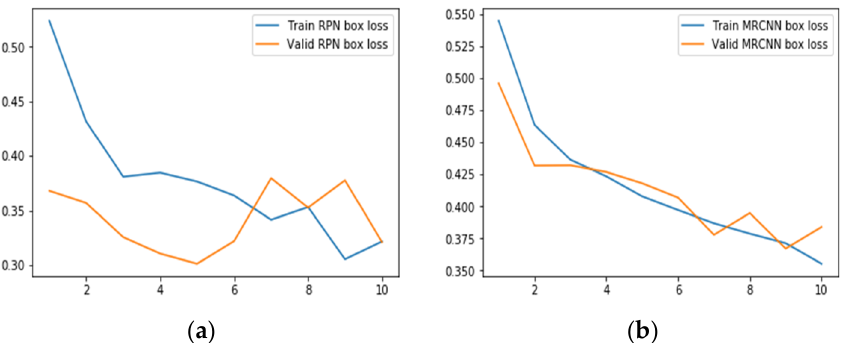
Figure 17. Bounding Box Regression loss for proposed Model with LR = 0.0006, Epochs = 10, ( a ) RPN bbox loss; ( b ) MRCNN bbox loss.